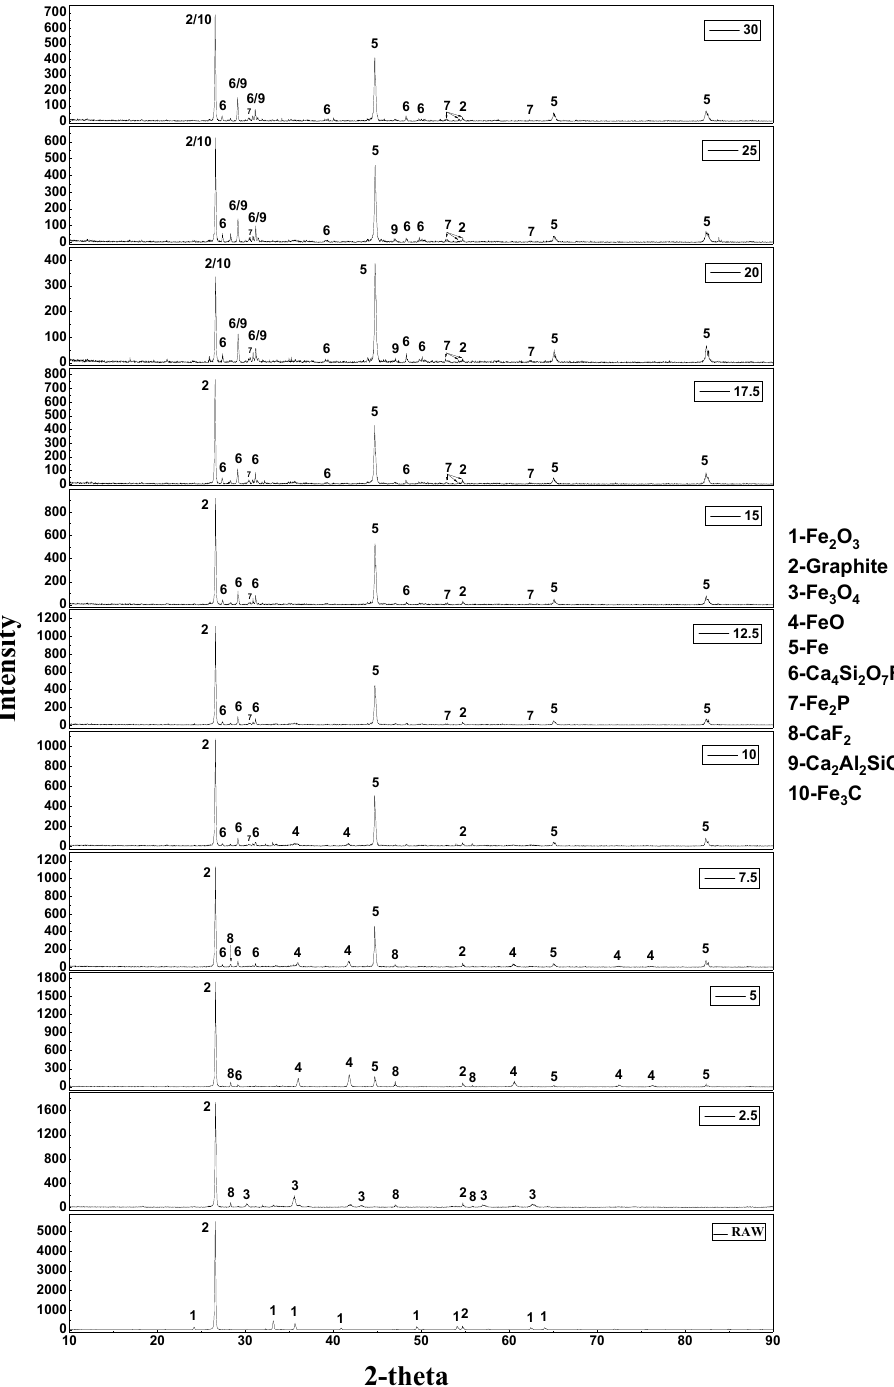
Figure 11. XRD spectra of reduced pellets at different times under vacuum condition.